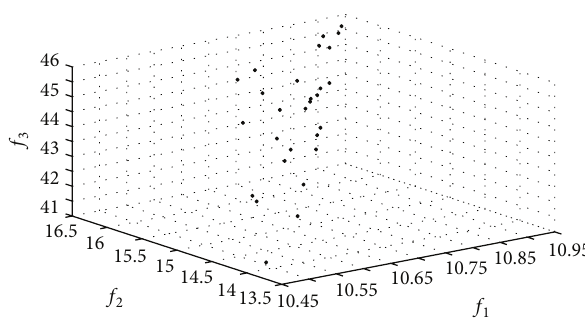
Figure 5: The Pareto frontiers of the HDE algorithm.